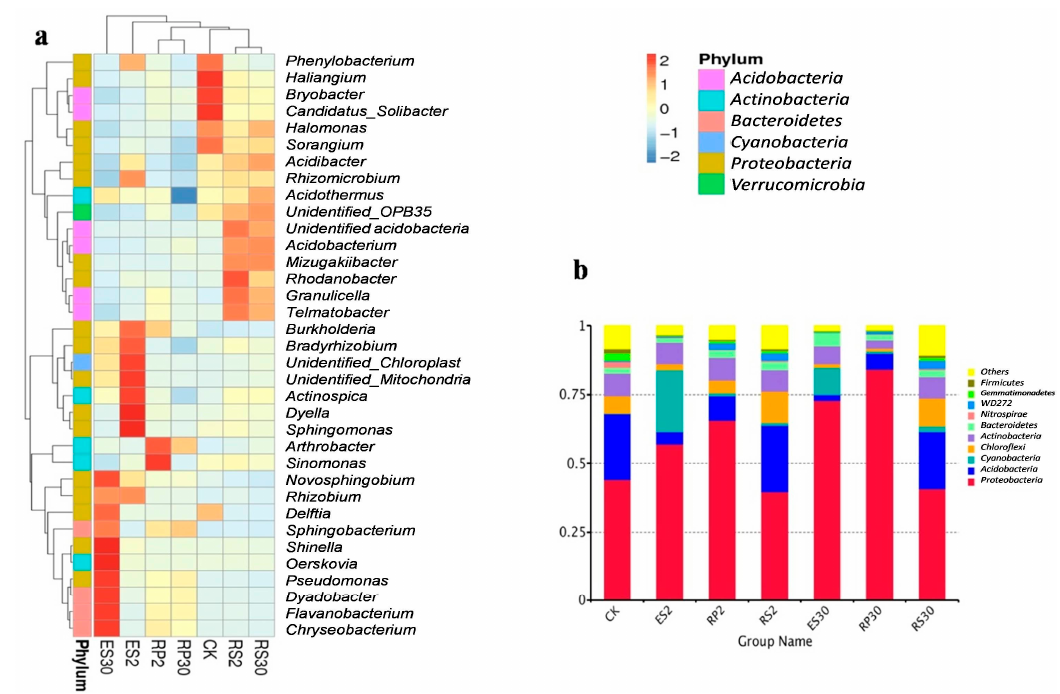
Figure 3. ( a ) Heat map showing the distribution of the 35 most abundant genera. ( b ) Distribution of the top 10 most abundant phyla in bulk soil (CK), rhizosphere of the two-year-old tea plantation (RS2), rhizoplane of the two-year-old tea plantation (RP2), endosphere of the two-year-old tea plantation (ES2), rhizosphere of the thirty-year-old tea plantation (RS30), rhizoplane of the thirth-year-old tea plantation (RP30) and endosphere of the thirty-year-old tea plantation (ES30).